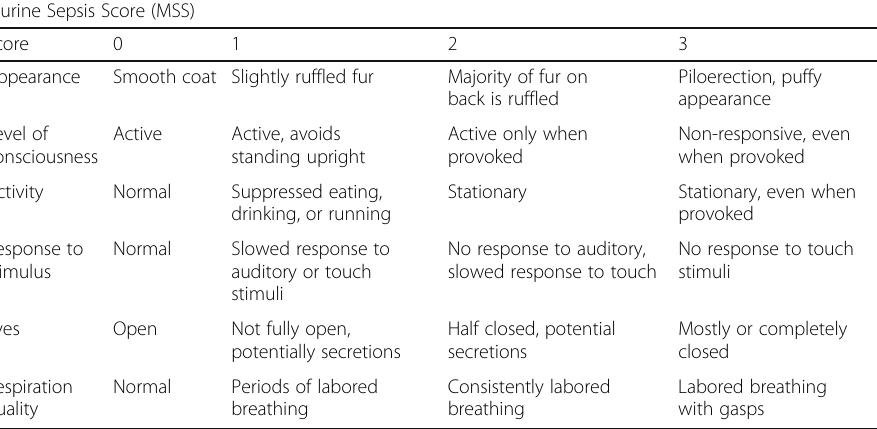
Table 1 Modified MSS scoring system for monitoring of surrogate endpoints and assessment of disease severity in mouse CLP sepsis, adapted from Shrum et al.